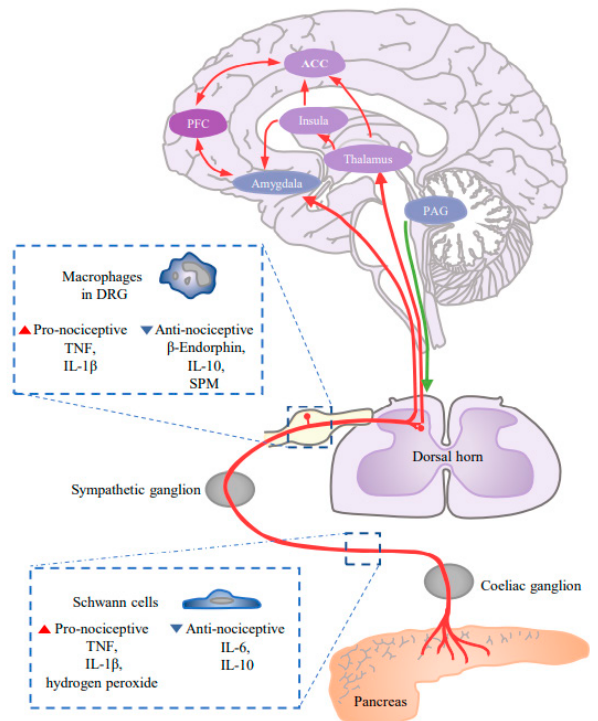
Figure 2. The alterations of pain conduction in PDAC patients. In the peripheral nervous system, local neurogenic inflammation in PDAC initiates the pain conduction. Schwann cells and macrophages regulate the process by the release of multiple pro-nociceptive factors. In the CNS, several pain-related brain regions undergo a series of reorganization and remodeling of synapses, contributing to the pain sensitization in PDAC patients. ACC, anterior cingulate cortex; PAG, periaqueductal gray; PFC, prefrontal cortex; SPM, specialized pro-resolving mediator.